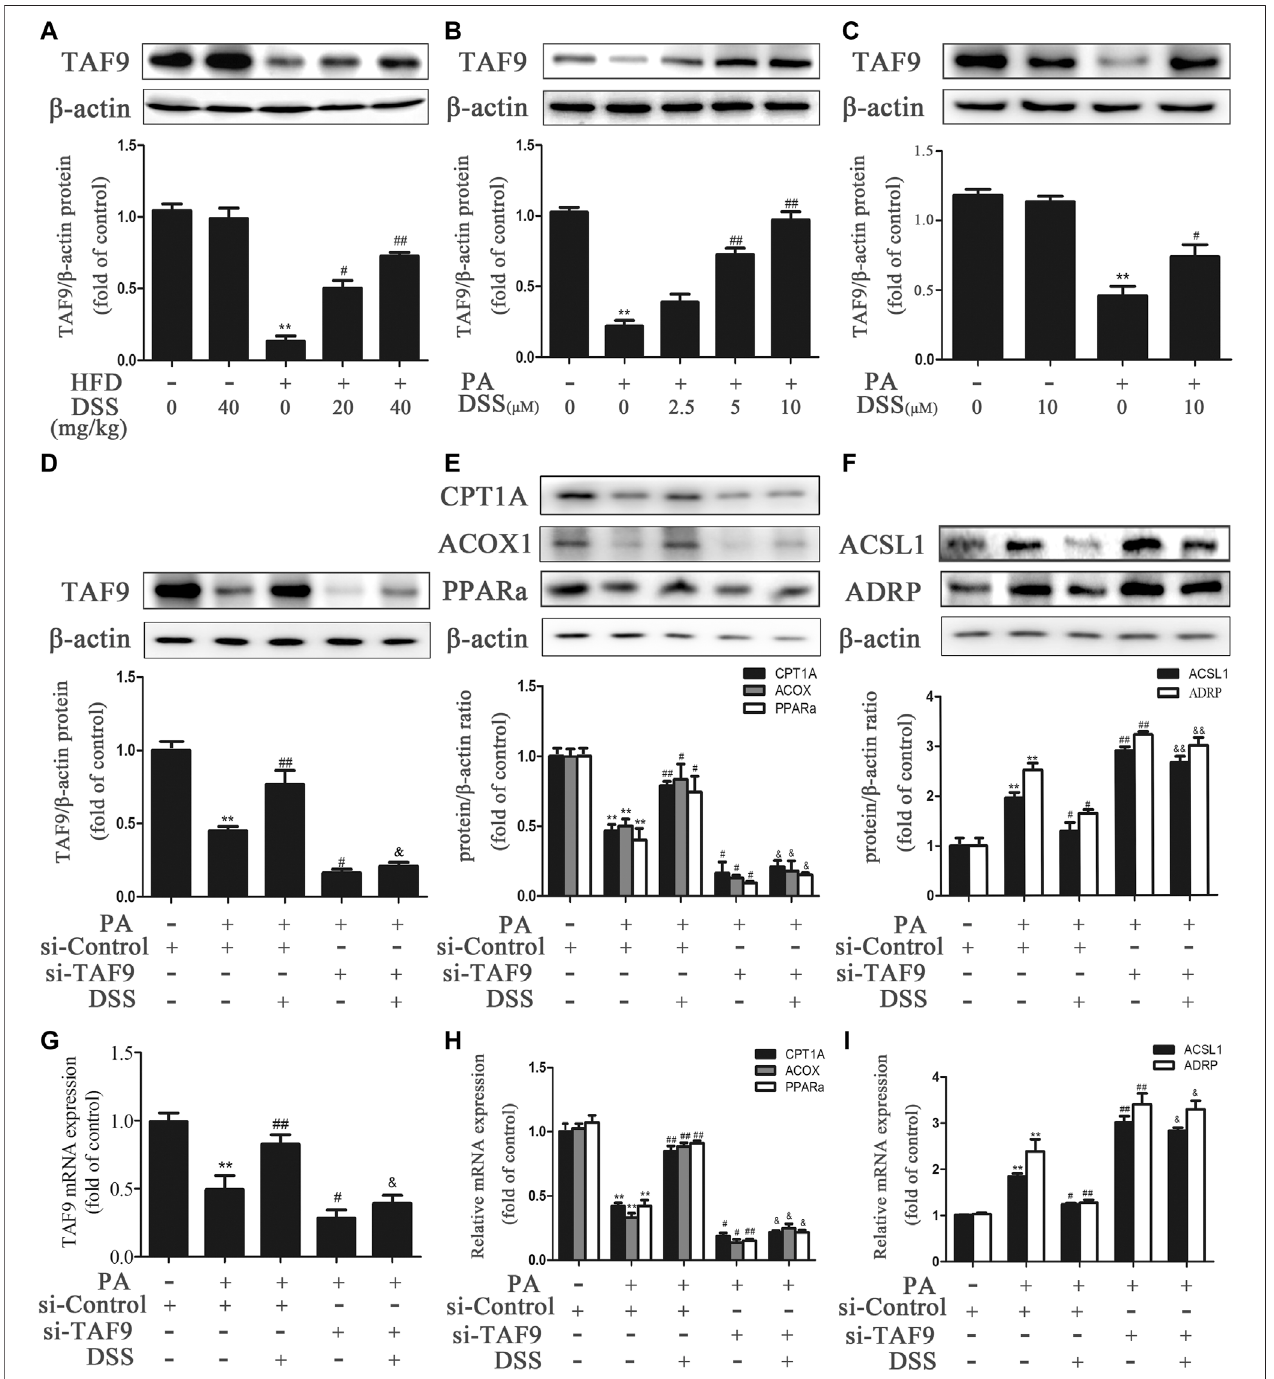
FIGURE4| DSSpromotes fatty acid β -oxidation and reduces LDaccumulationthroughTAF9 activation. (A) Proteinlevels ofTAF9in theliver ( n (cid:2) 3).** p < 0.01vs. theNDgroup; # p < 0.05, ## p < 0.01vs.theHFD group. (B,C) ProteinlevelsofTAF9inAML-12cells( n (cid:2) 3). ** p < 0.01vs. thecontrolgroup; # p < 0.05, ## p < 0.01vs. the PA group. (D – I) AML-12 cells were transfected withacontrol siRNA or TAF9 siRNA for48h, and thenthe transfected cellsweretreated withDSS (10 μ M) for 6 h before exposure to PA (0.4 mM) for another 24 h. Protein ( n (cid:2) 3) and mRNA ( n (cid:2) 6) levels of TAF9, fatty acid β -oxidation-related genes (CPT1A, ACOX1 and PPAR α ) and LD accumulation-related genes (ACSL1 and ADRP) in AML-12 cells. ** p < 0.01 vs. the si-control group; # p < 0.05, ## p < 0.01 vs. the si-control + PA group; & p < 0.05, && p < 0.01 vs. the PA + DSS group.